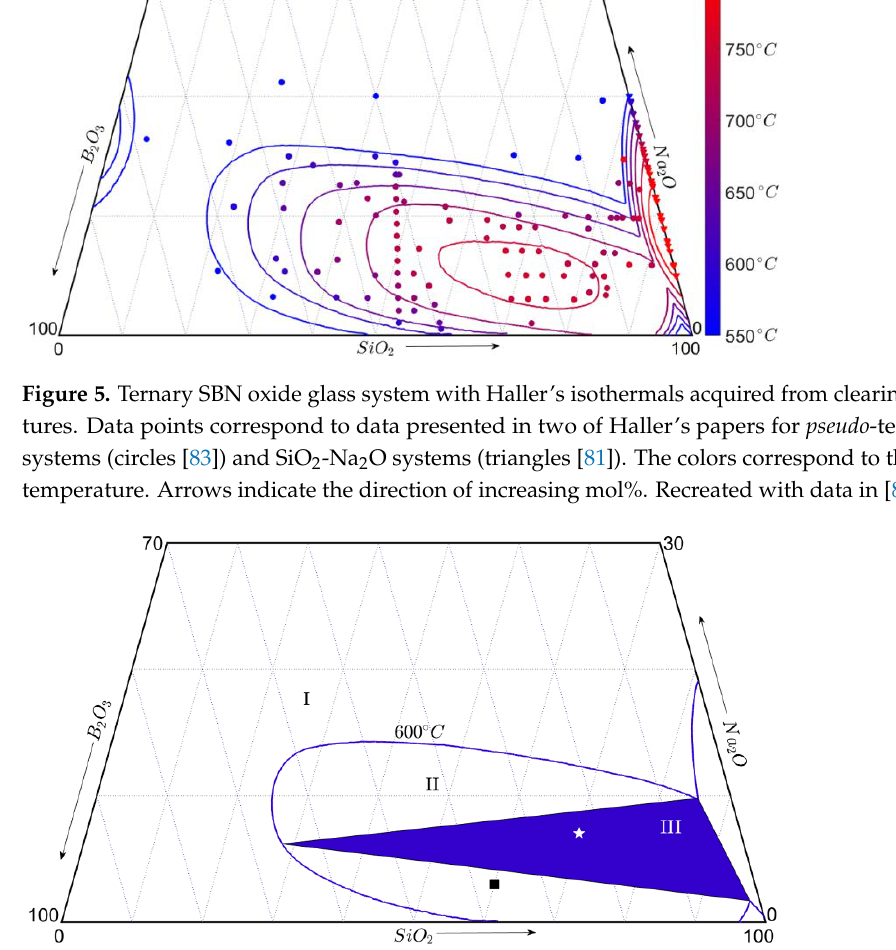
Figure 6. Immiscibility diagram posed by Haller for SBN glass systems at 600 °C [83]. The line marks the 600 °C isothermal as seen in Figure 5. It represents the border between one-phase (Zone I) and multi-phases (Zones II and III). The blue solid triangle indicates the 3-phase zone. Data points correspond to data presented in Section 4.1.1 (black square [94]) and 4.1.2 (white star). Arrows indicate the direction of increasing mol%. Recreated with data in [83].